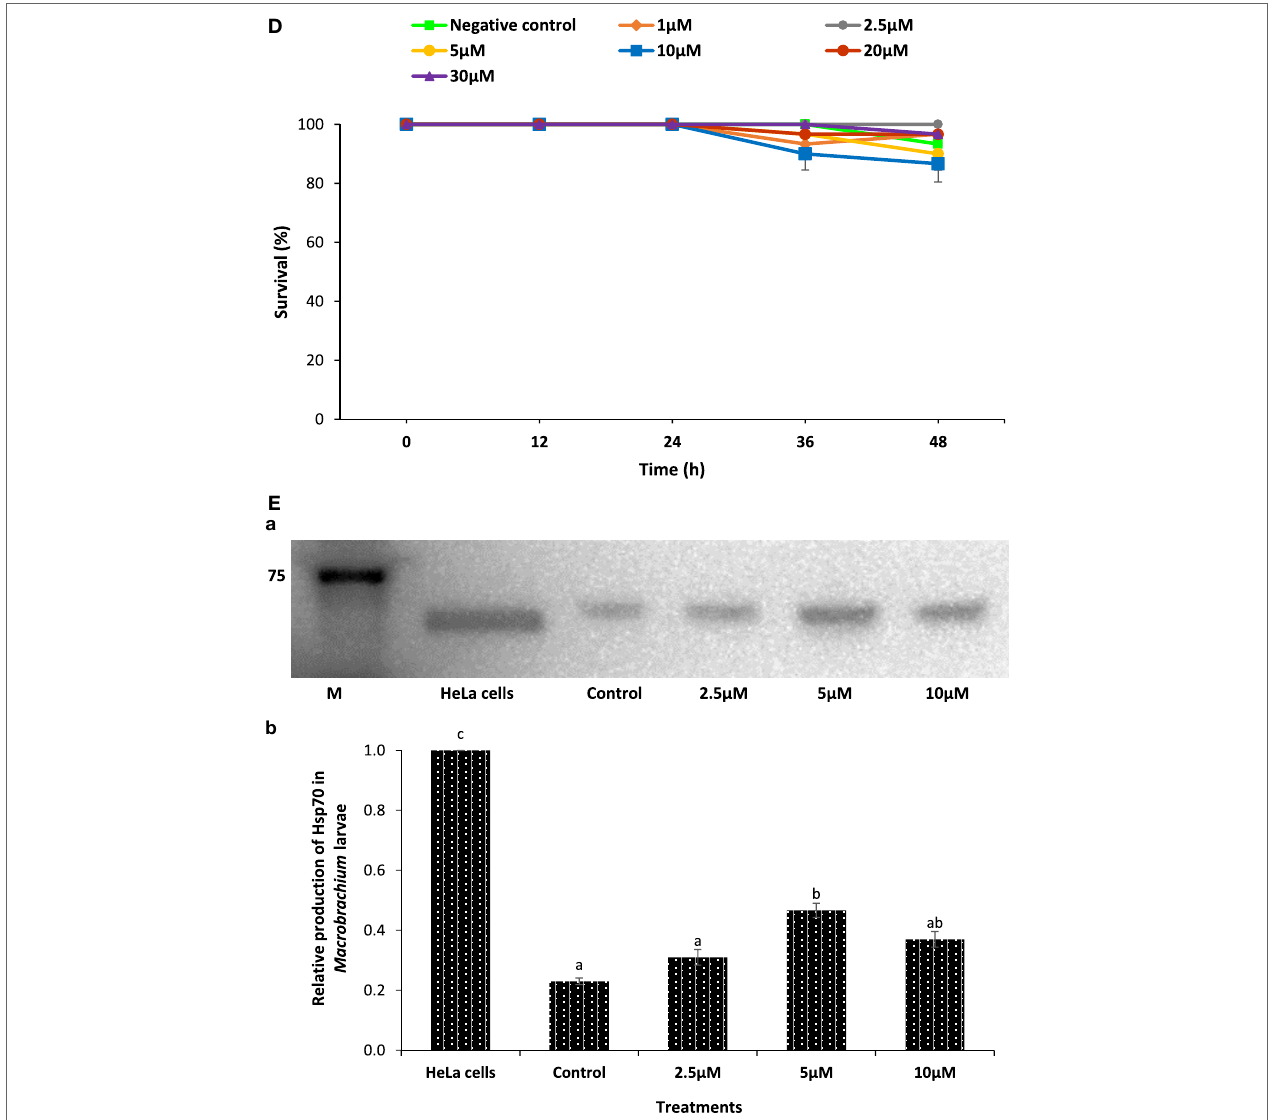
FigUre 4 | Pretreatment of xenic brine shrimp larvae and Macrobrachium larvae with phloroglucinol protects them against subsequent Vibrio parahaemolyticus challenge. (a) Survival (%) of phloroglucinol-pretreated xenic brine shrimp larvae after 48 h of challenge with V. parahaemolyticus MO904. The larvae were pretreated with phloroglucinol at the indicated doses for 2 h, rinsed to wash away the compound, and then allowed to recover for 2 h. The larvae were subsequently challenged with V. parahaemolyticus at 10 7 cells/ml of rearing water. Non-pretreated larvae that were either challenged with V. parahaemolyticus (positive control) or unchallenged (negative control) served as controls. Error bars represent the standard error of five replicates; different letters indicate significant differences ( P < 0.001). (b) Proportion of survived of Macrobrachium larvae (8 days old) after 12, 24, 36, and 48 h post challenge with V. parahaemolyticus MO904 strain. Four infectious doses (10 4 , 10 5 , 10 6 , and 10 7 cells/ml) were tested in the Macrobrachium larvae. The V. parahaemolyticus dose provoking significant mortality near to 80% at 24 h in Macrobrachium larvae was considered an optimum dose and selected for the experimental challenge. The unchallenged was served as negative controls. Values are presented as mean ± SE ( n = 3). (c) The effect of phloroglucinol pretreatment on the survival of Macrobrachium larvae (8 days old) after 12, 24, 36, and 48 h post challenge with V. parahaemolyticus . The larvae were pretreated with phloroglucinol at the indicated doses for 2 h, rinsed to wash away the compound, and then allowed to recover for 2 h. The Macrobrachium larvae were subsequently challenged with V. parahaemolyticus at 10 6 cells/ml of rearing water. Non- pretreated larvae that were either challenged with V. parahaemolyticus (positive control) and those not challenged with V. parahaemolyticus (negative control) served as controls. Values are presented as mean ± SE ( n = 3). Asterisks represent significant difference between the control and the treatment. * P < 0.05, ** P < 0.01, *** P < 0.001, **** P < 0.0001, ***** P < 0.00001, ****** P < 0.000001, ******* P < 0.0000001. (D) Toxicity of phloroglucinol to Macrobrachium larvae (8 days old). The larvae were pretreated with phloroglucinol at the indicated doses for 2 h, rinsed to wash away the compound, and then allowed to recover for 2 h. Non-pretreated larvae served as controls. Survival was recorded 48 h after the recovery period. Values are presented as mean ± SE ( n = 3). (e) Induction of Hsp70 protein in Macrobrachium larvae (8 days old) pretreated with phloroglucinol at indicated doses. Non-pretreated larvae were maintained as control. (a) Protein extracted from different treatment groups was resolved on an SDS-PAGE gel and then transferred to a polyvinylidene fluoride membrane and probed with an antibody to brine shrimp Hsp70. Molecular mass standards (M) in kilodaltons are shown on the left. The induction of Hsp70 in HeLa cells was regarded as 1. (b) Quantitative analysis of Hsp70 levels in the brine shrimp larvae is presented relative to Hsp70 production in HeLa cells. Error bars represent the standard error of three replicates; different letters indicate significant differences ( P <